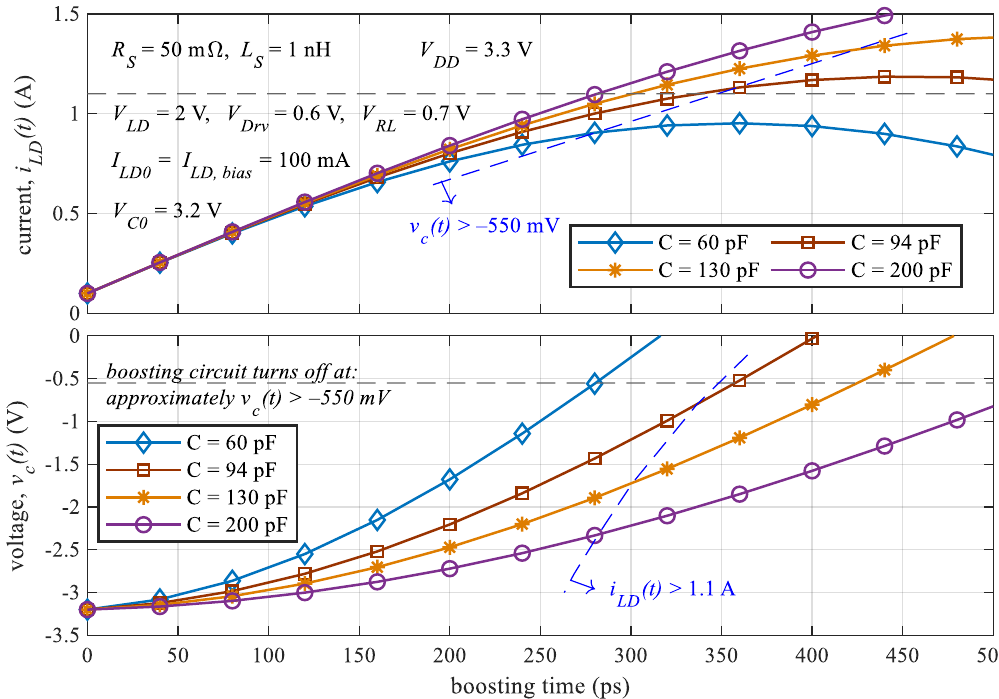
Figure 6. Various drive current transitions using Equation (8) over boosting time for different boosting capacitor sizes. An optimal boosting capacitor selected from this example is 94 pF.